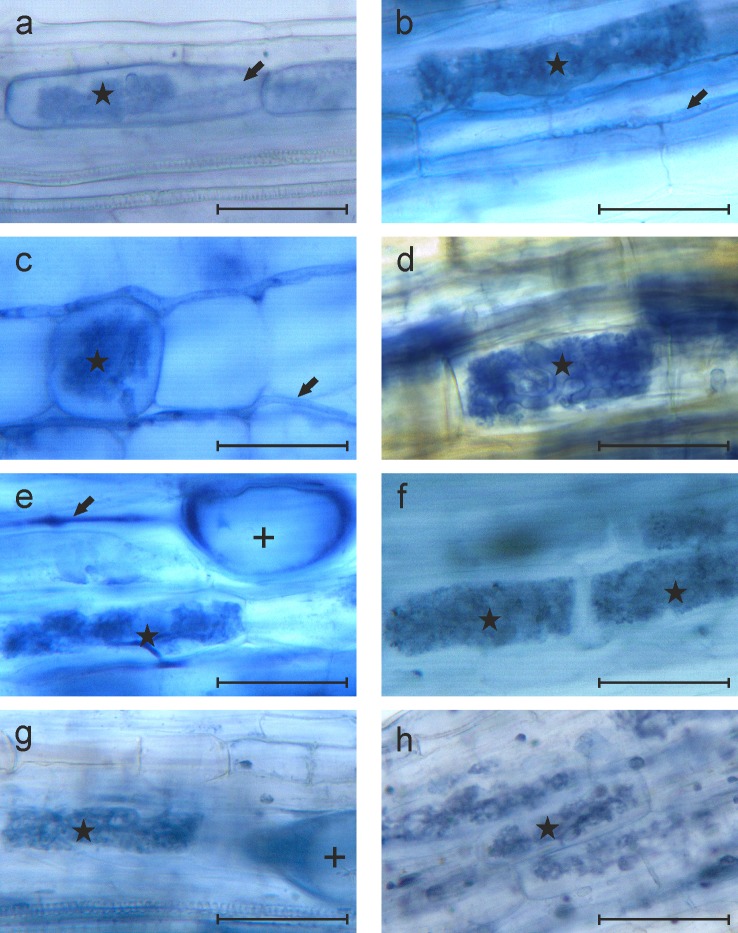
Microscopic images of AMF structures in roots of eight plants co-inoculated with R. irregularis and B. amyloliquefaciens from the second experiment.(a−h) Images from C. rotundifolia (a), L. corniculatus (b), T. repens (c), G. sanguineum (d), F. vesca (e), V. tricolor (f), T. serpyllum (g), and A. dioica (h). Scale bars represent 50 μm. A black arrow, a + symbol, and a star indicate a hypha, vesicle, and arbuscule, respectively.